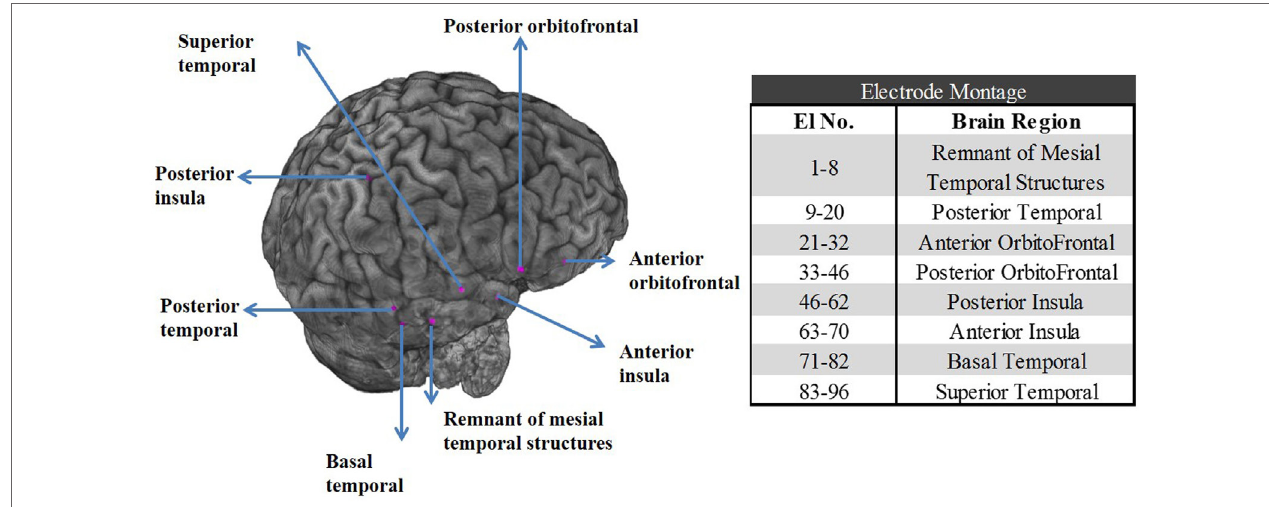
FigUre 1 | Left panel: Postoperative CT scan merged with preoperative MRI shows the location of the stereoelectroencephalographic electrodes in the right temporal and orbitofrontal structures for patient PT1. Right panel: Table with the electrode contact numbers and the corresponding eight brain regions the electrodes were implanted